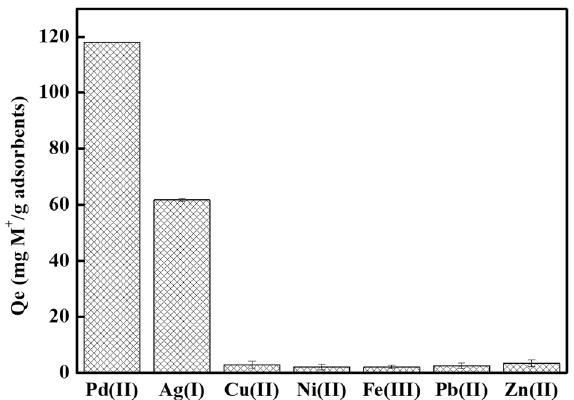
Figure 4. Selective adsorption of ATU-PEGDA for multiple metal ions under pH 1 condition at 25 °C. The initial concentration of each metal ion was 100